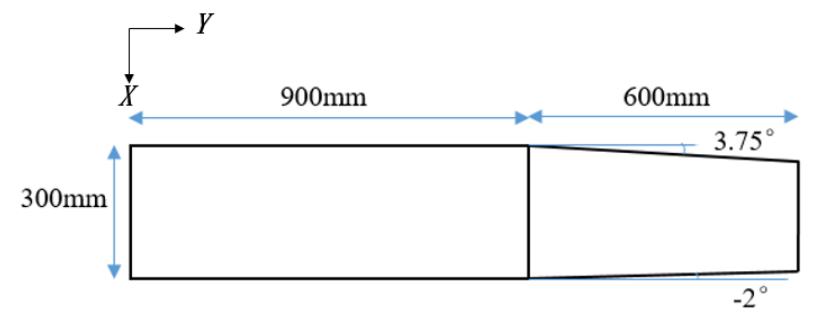
Figure 2. Plane shape of the semi-wing.